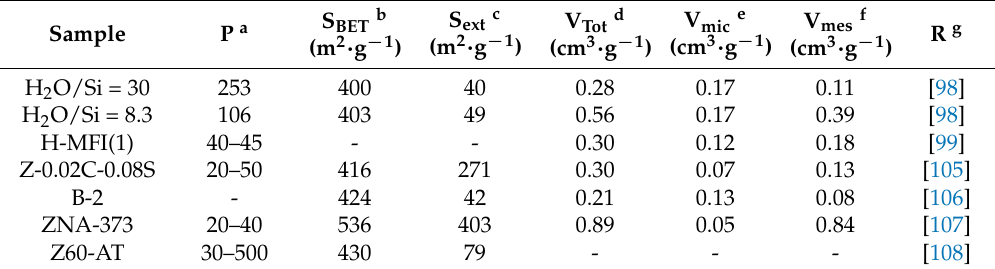
Table 4. Textural properties of nano-sized ZSM-5 zeolite in the references.